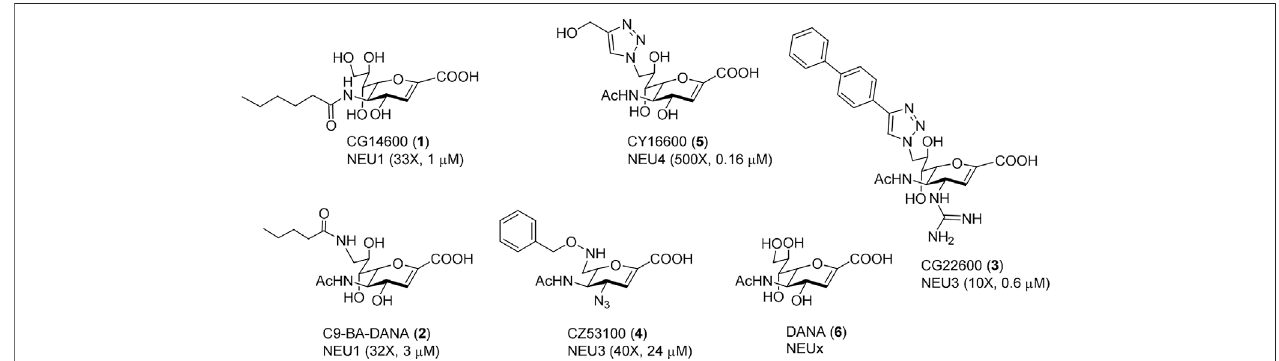
FIGURE 3 | Selective human NEU inhibitors used in this study. Inhibitors were selected from previous reports for selectivity against different human NEU isoenzymes.Each compound isshown withauniqueidenti fi erand acompoundnumber used inthiswork.Theisoenzyme whichtheinhibitor targets isgiven,alongwith thefold-selectivity(ascomparedtoitsnext-bestNEUtarget),alongwithitsreportedIC 50 value.Compound 1 (Guoetal.,2018a)and 2 (Mageshetal.,2008)areselective NEU1 inhibitors. Compound 3 (Guo et al., 2018b) and 4 (Zhang et al., 2013) are selective NEU3 inhibitors. Compound 5 (Albohy et al., 2013) is a selective NEU4 inhibitor. Compound 6 is a general inhibitor with activity for all human NEU isoenzymes (Richards et al.,